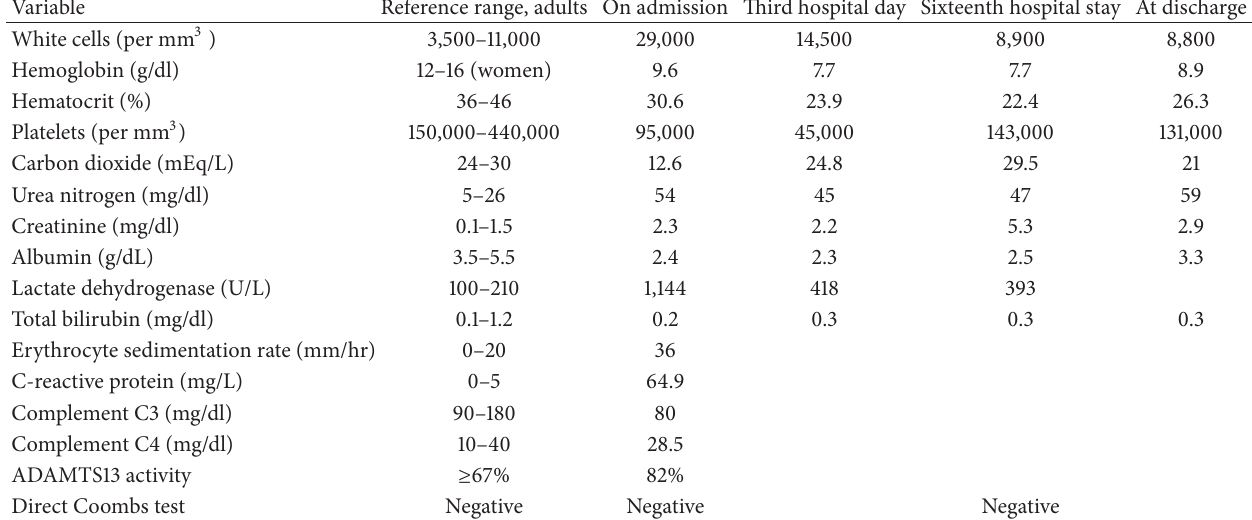
Table 1: Laboratory